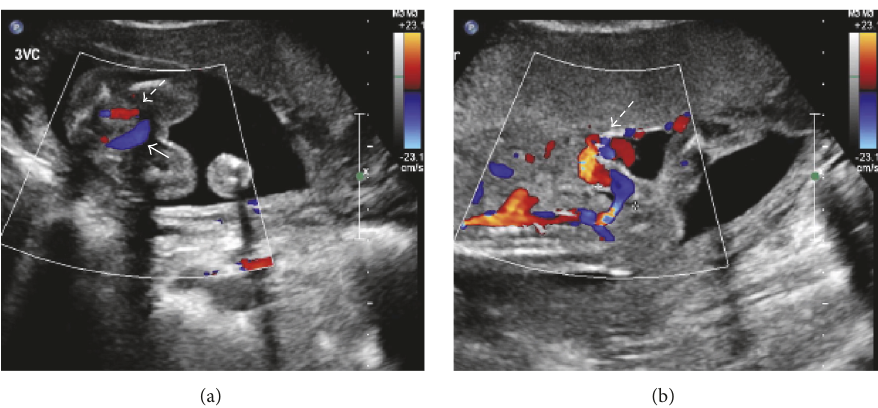
Figure 4: Transverse (a) and longitudinal (b) prenatal sonographic images demonstrating atypical umbilical venous anatomy at the level of the bladder. The transverse image demonstrates vessels coursing from the umbilicus into the fetus on either side of the bladder but with different Doppler flow directions indicating umbilical artery and vein. The longitudinal image demonstrates cord insertion and both arterial and venous flow into the fetal pelvis prior to joining the iliac vessels. Of note, there is no Doppler flow from cord insertion directly to the